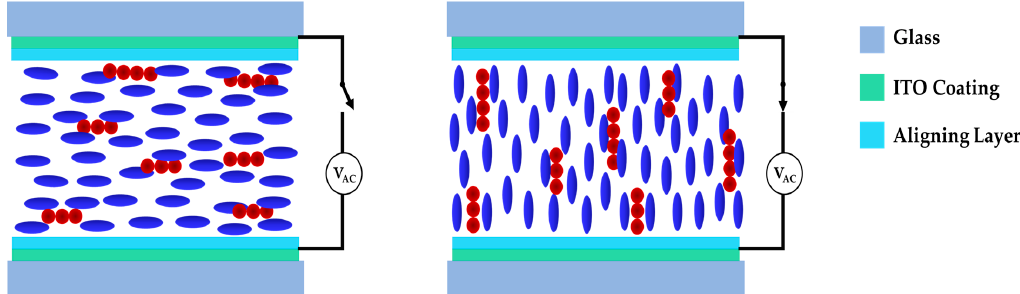
Figure 18. The self-assembly and reorientation of quantum dots (QD) in a nematic LC matrix by electric field. (The LC molecules are colored blue, and the CdS QDs are sphere with purple color.) The discussion above indicates the possibility of field-induced conductivity modulation in the